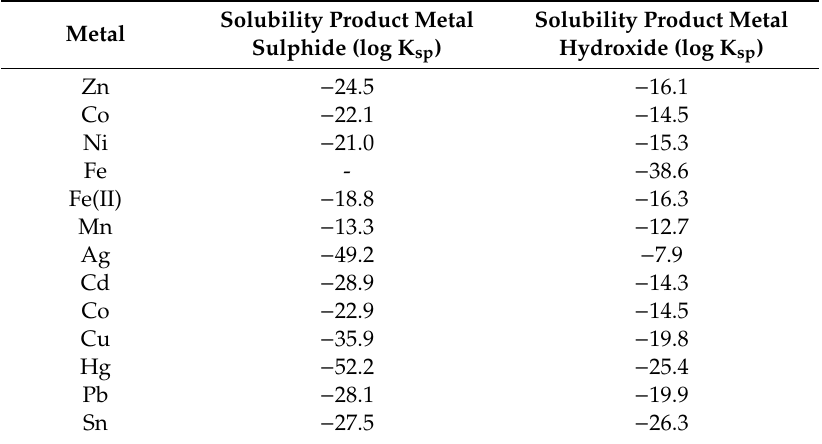
Table 1. Theoretical values for metal sulphide and hydroxide precipitation [7].